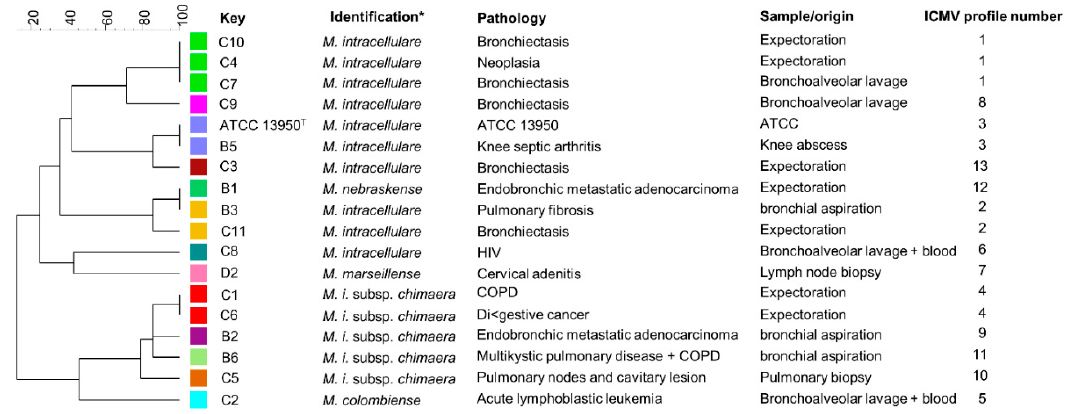
Figure 1. Genetic diversity of clinical strains. Clinical isolates were genotyped by Multilocus Variable numbers tandem repeats Analysis (MLVA) based on 7 markers. The MLVA-based polymorphism dendrogram was made with Bionumerics. MLVA profiles are represented by a color. key, strain name; ICMV, M. intracellulare MLVA, * Species were identified by hsp65 sequencing. T, type strain. Chronic obstructive pulmonary disease (COPD). Table 1. Bacterial strains and plasmid.